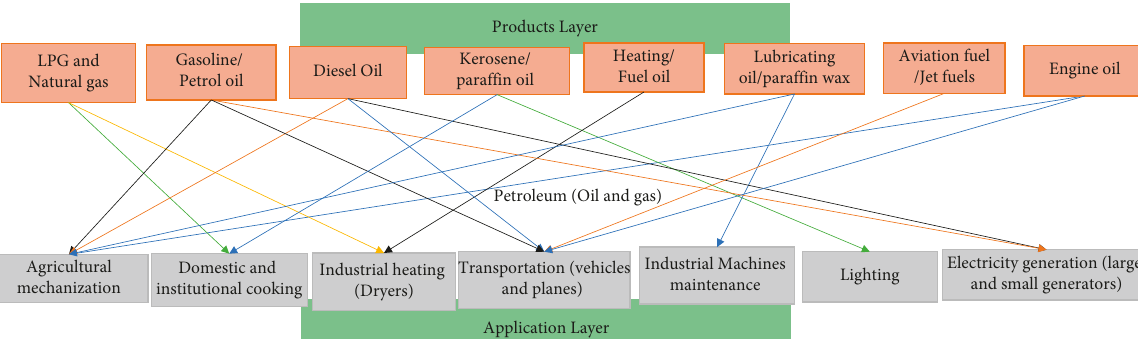
Figure 3: Applications of petroleum products.